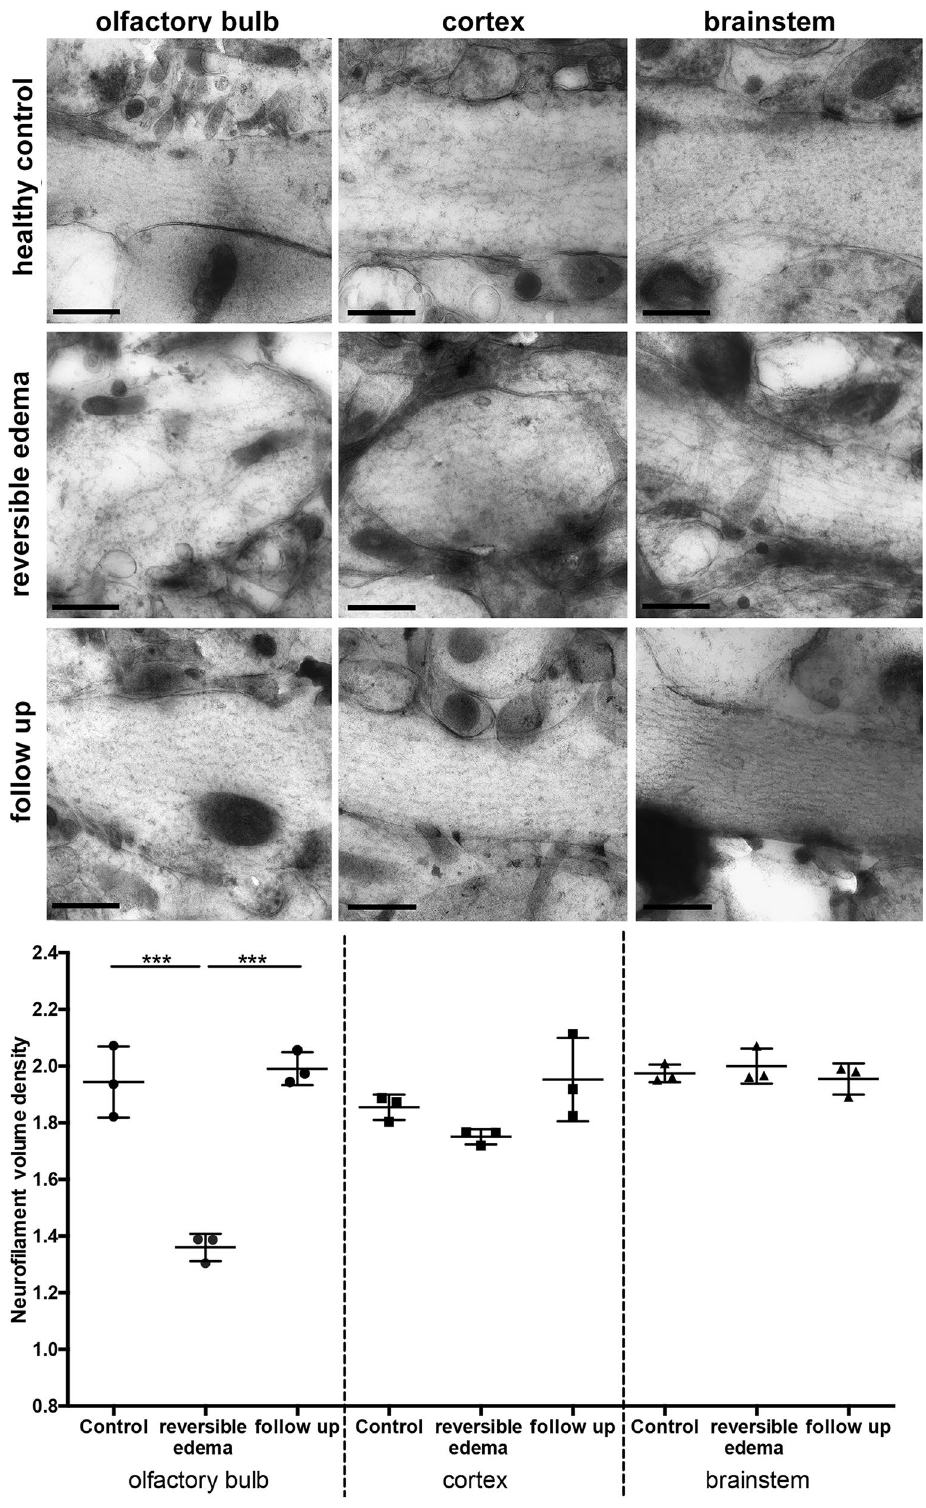
Figure 4. Neurofilaments in different anatomical regions at 3 months follow-up. EM images show representative neuronal processes for the following brain regions: olfactory bulb (OB), cortex and brainstem, each in healthy control, during reversible edema and in the follow-up three months after the edema. Mice show a regeneration of neurofilament density in the follow-up three months after infection. Moreover, the morphology of neurofilament networks reverses to an intact state similar to the control group. Scalebar equals 200 nm. (n healthy control = 3 per region, n reversible edema = 3 per region, n reversible edema chloroquin = 3 per